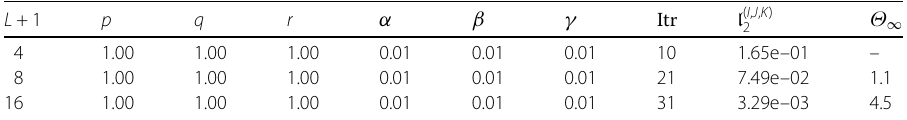
Table 5d Errors and order for UM-FOCS in Example 5.5 at (cid:2) = 0.01